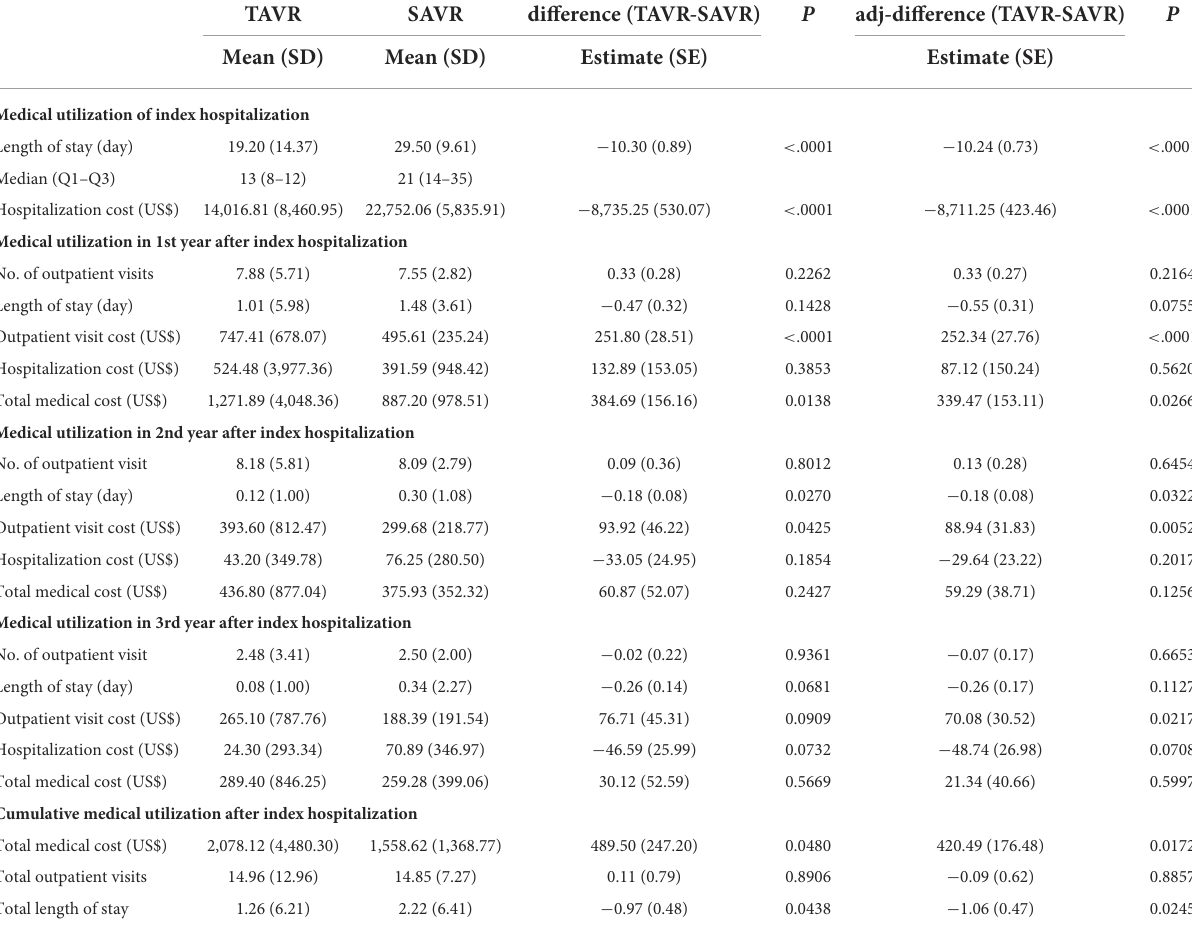
TABLE 3 Medical utilization during surgery and in different post-procedure periods after propensity score overlap